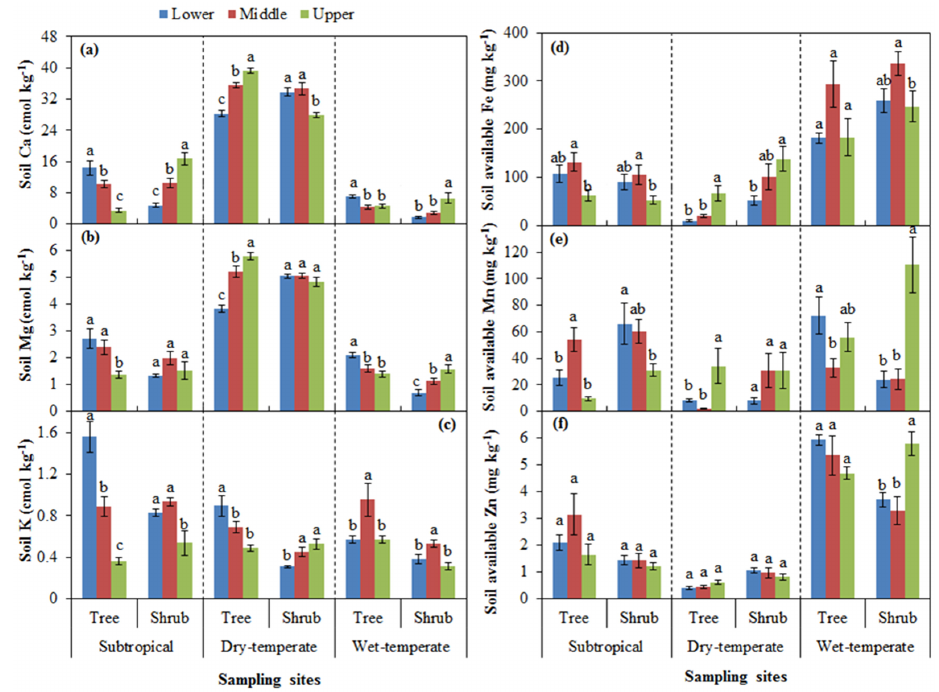
Figure 2. Concentrations of soil exchangeable base cations of Ca (a) , Mg (b) and K (c) and available micronutrients of Fe (d) , Mn (e) , and Zn (f) at lower and middle elevations as well as at the upper limit of trees and shrubs for each of the three sites. Different letters indicate significant differences among three elevations within tree and shrub lines for each